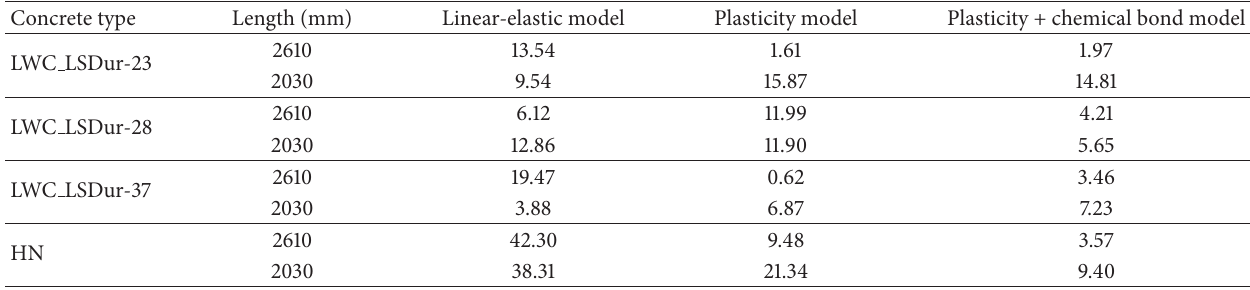
Table 9: Comparison of errors (%) of the different models at the linear-elastic